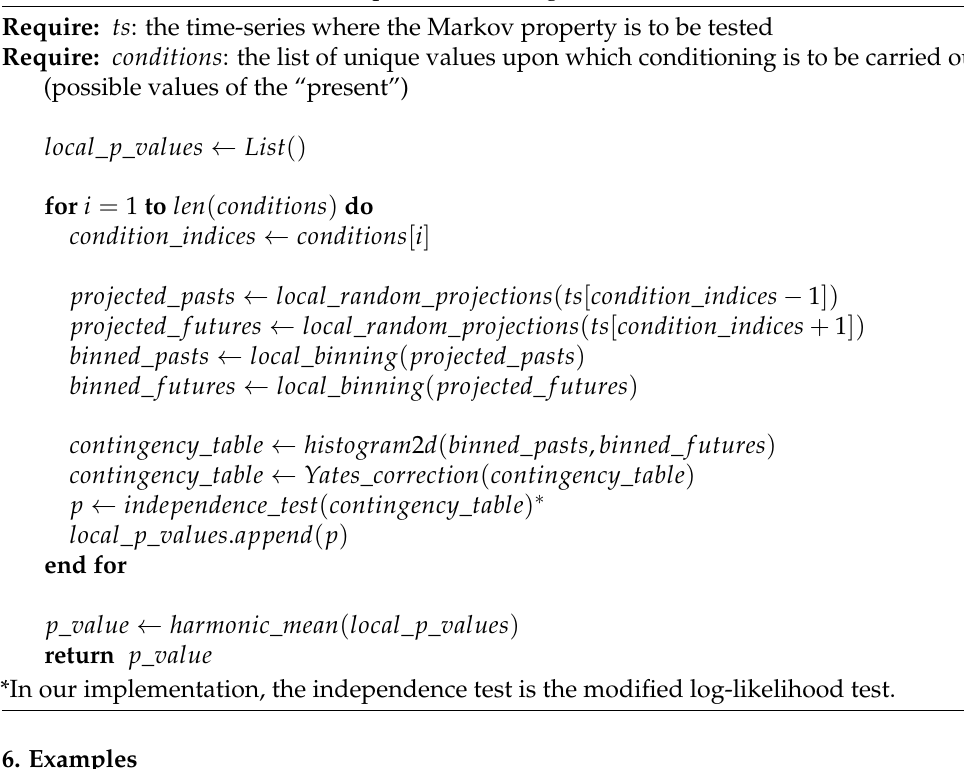
Algorithm 2 p _ markov ( ts , conditions ) : The function responsible for testing Markovness of a time series (via conditional independence